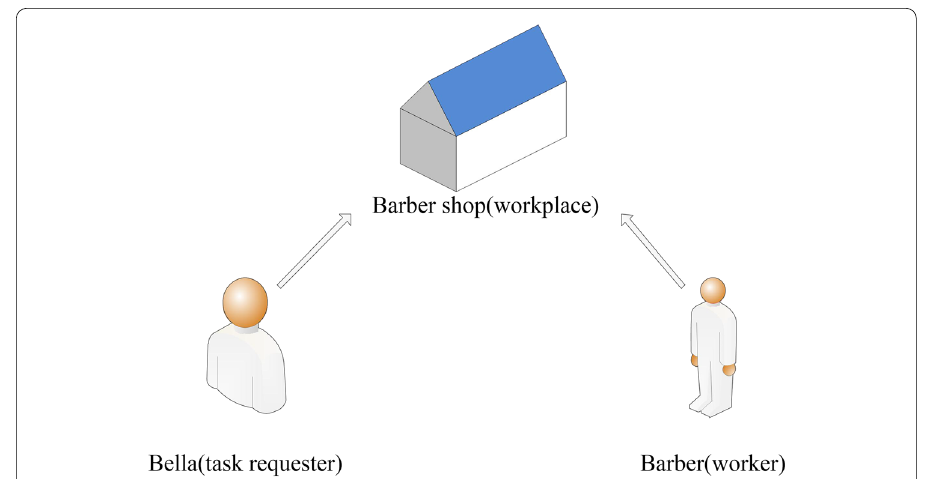
Fig. 1 Three-objective online task